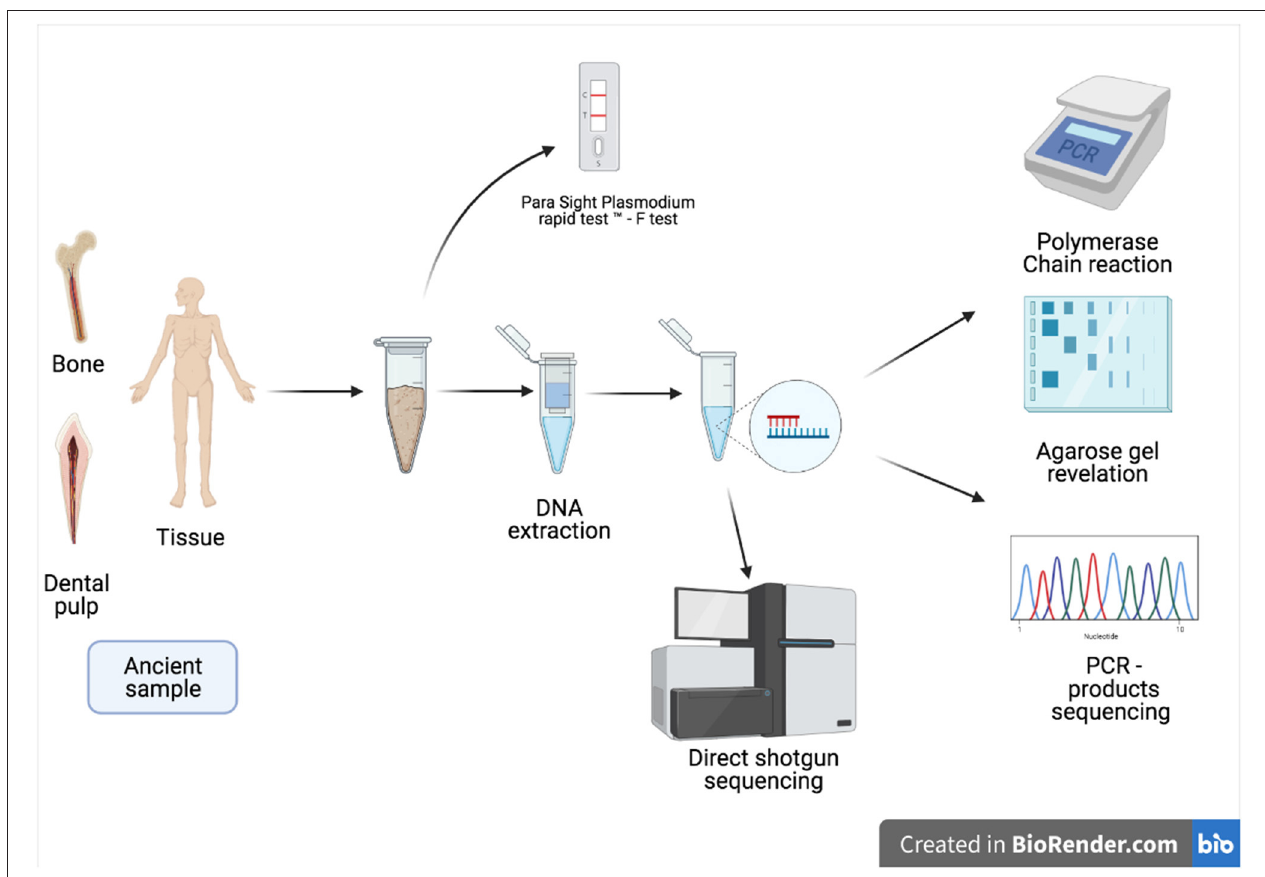
FIGURE 5 | Schematic presentation of the techniques used in the diagnosis of malaria in ancient samples.